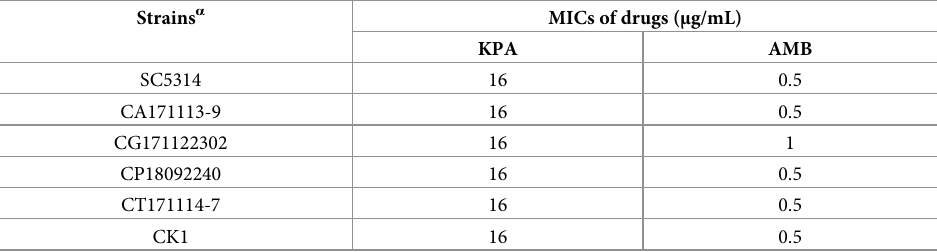
Table 1. The MICs values of KPA against different Candida